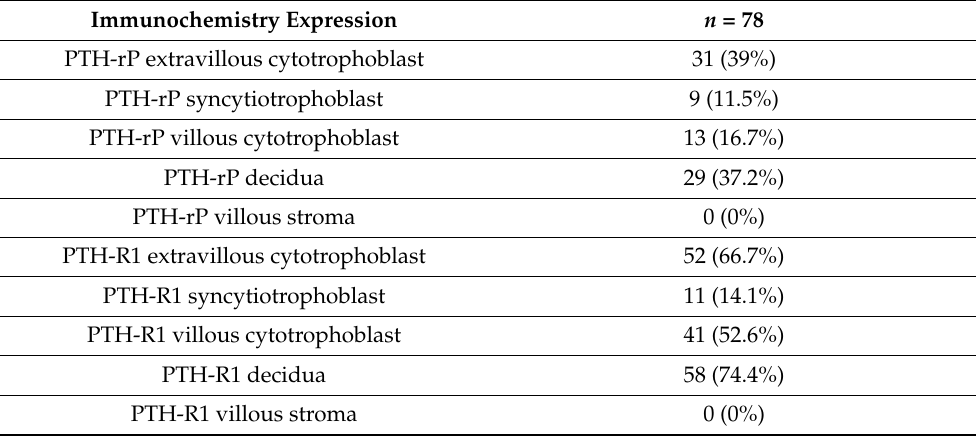
Table 2. PTH-rP and PTH-R1 immunochemistry positivity according to the placental